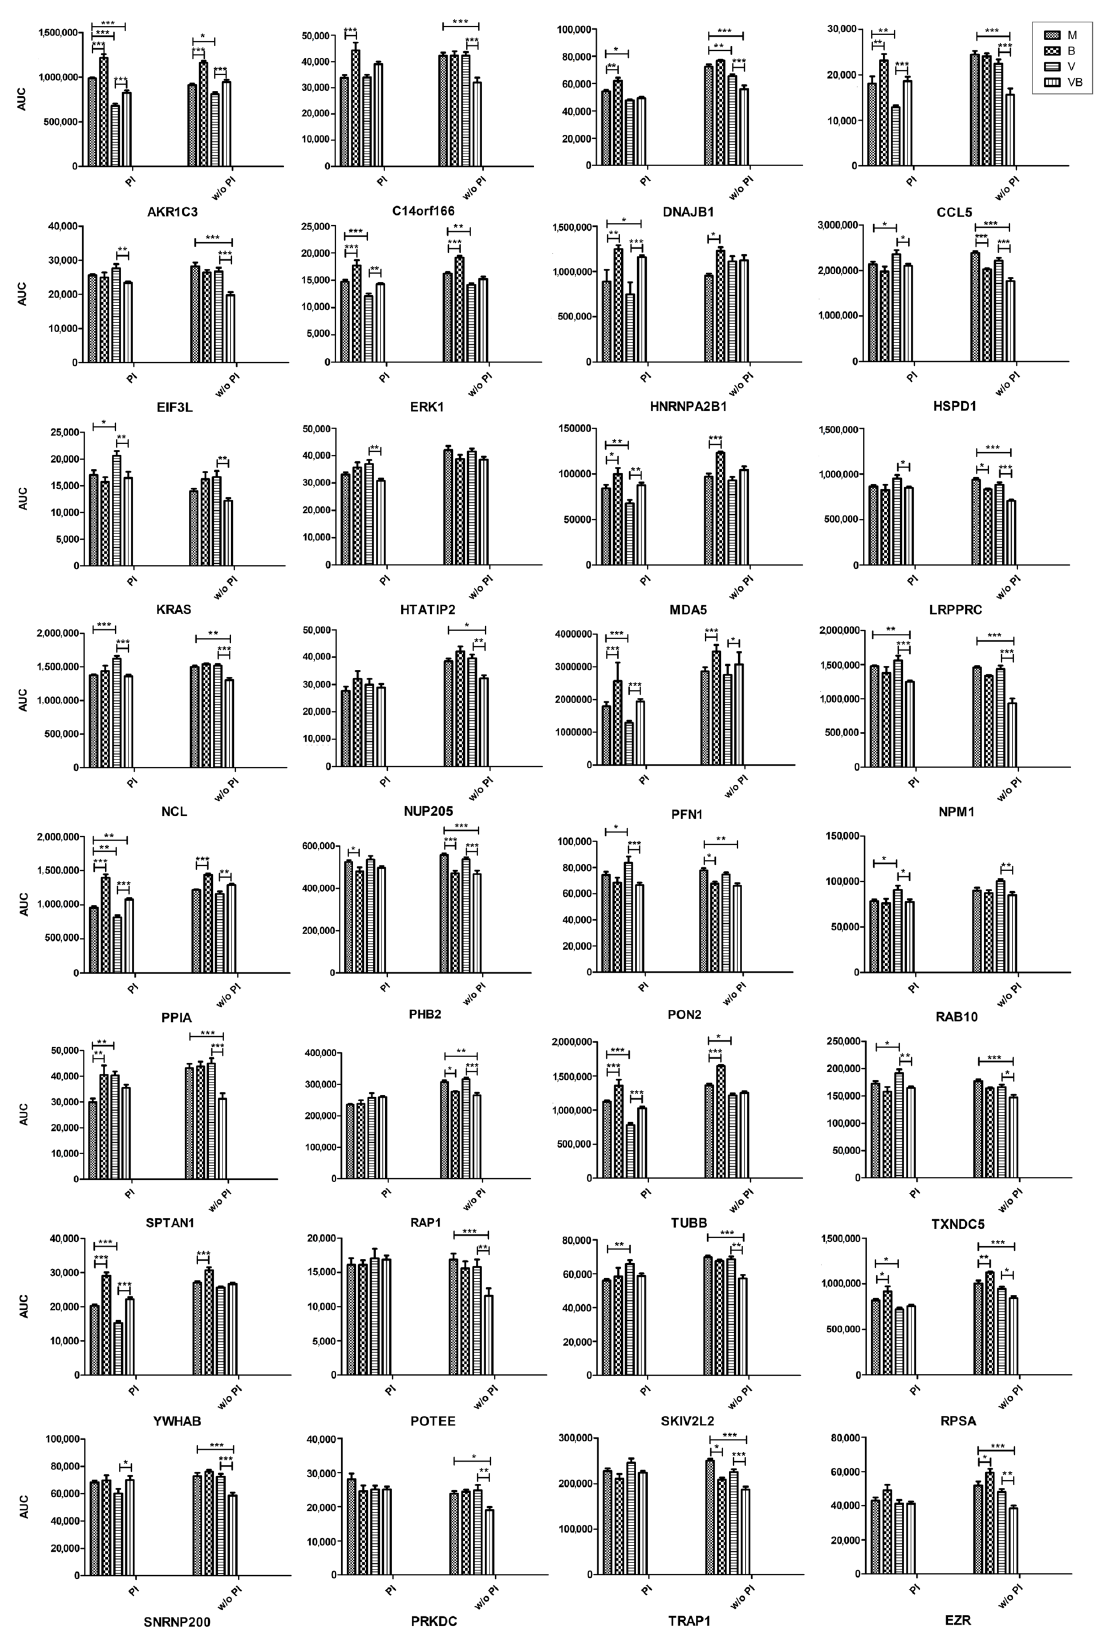
Figure 4. Relative protein quantities in mock-treated (M), binase-treated (B), virus-infected (V), and virus-infected binase-treated (VB) samples as determined by targeted liquid